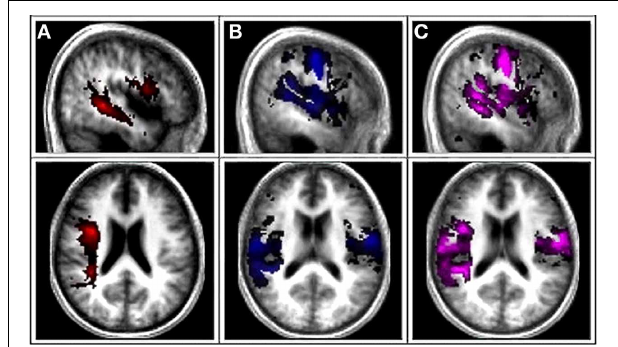
FIGURE 1 | Canonical AF, Functional gray matter (fGM), and Combined AF-fGM maps. (A) First column is the canonical probabilistic map of AF tract derived from DTI overlaid onto a normalized averaged T1 brain in MRIcon. (B) Second column shows the canonical map of functional gray matter map. (C) Third column displays combined canonical map of combined AF-fGM